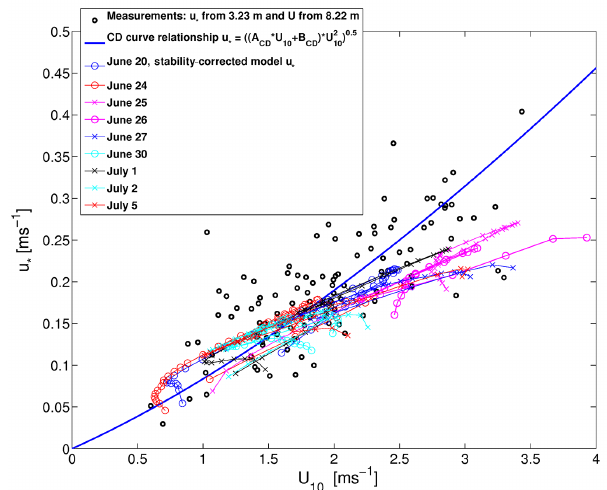
Figure 1. Measured hourly averaged u ∗ from the 3.23m level is shown as a function of wind speed at 8.22m in black circles. Here all measurements in unstable conditions for the studied IOP days are shown. The model u ∗ prediction from a simple CD curve relation- ship with A CD = 2 × 10 − 3 sm − 1 and B CD = 5 × 10 − 3 (unitless) is shown as a blue line. The model stability-corrected u ∗ values for nine IOP days are also shown in different colored lines with circles or crosses as a function of the 10m model wind speed for every 20min during the